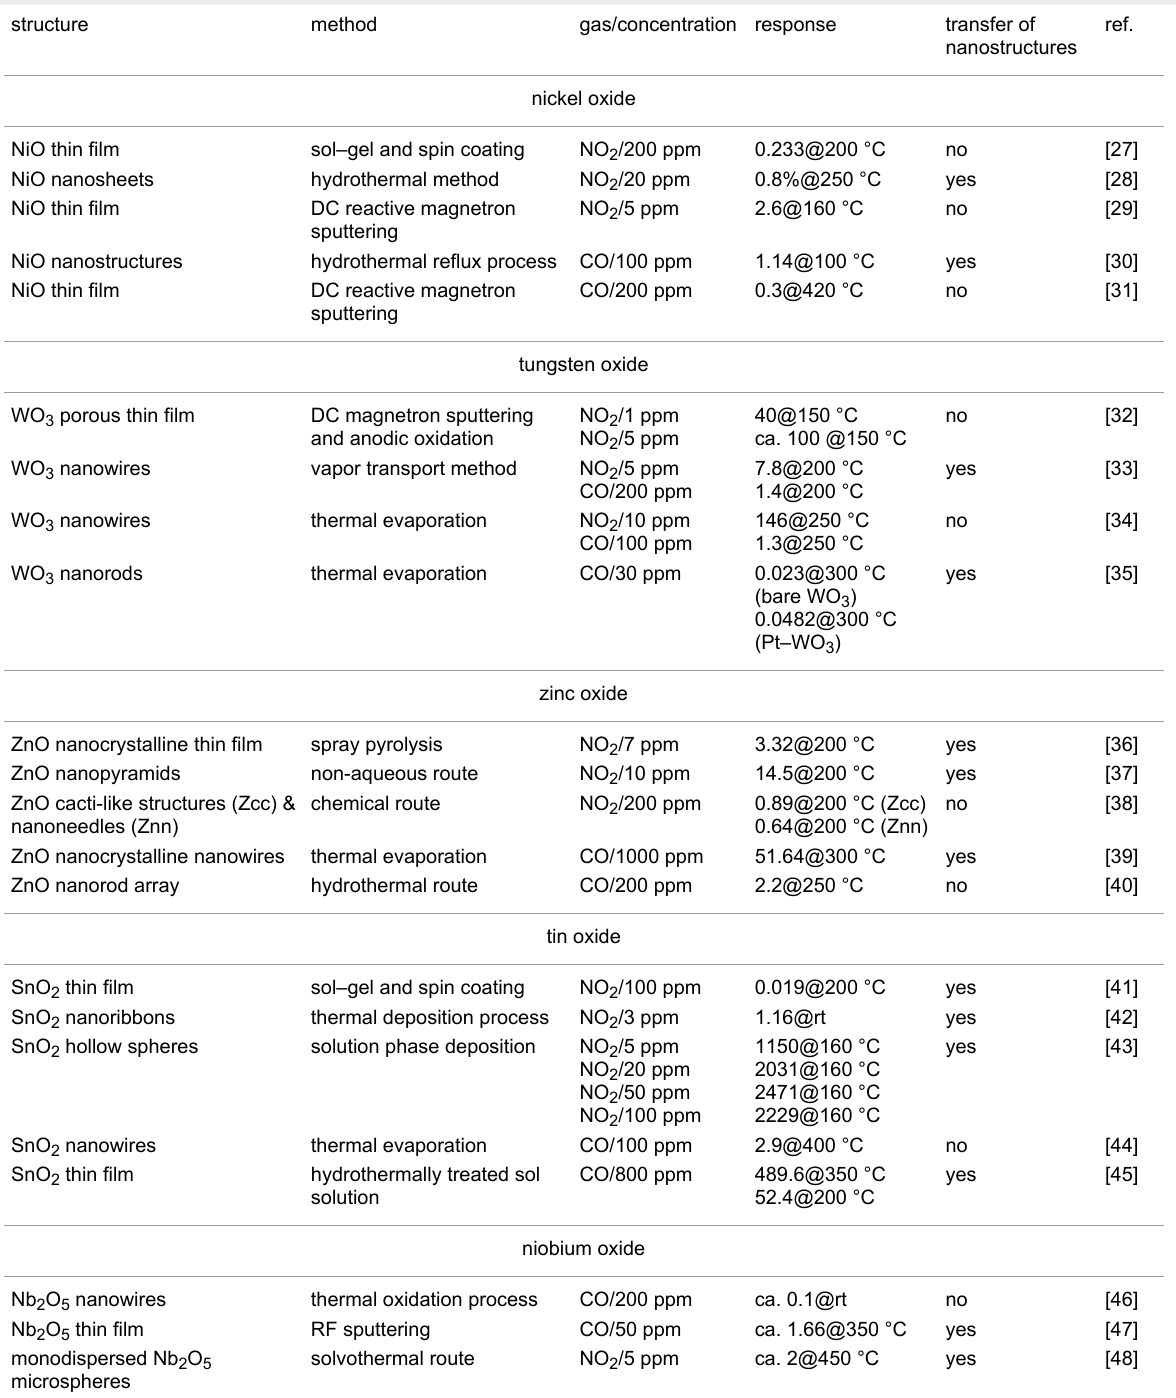
Table 1: Sensing performance reported in literature for some similar metal oxide nanostructures toward CO and NO 2 .